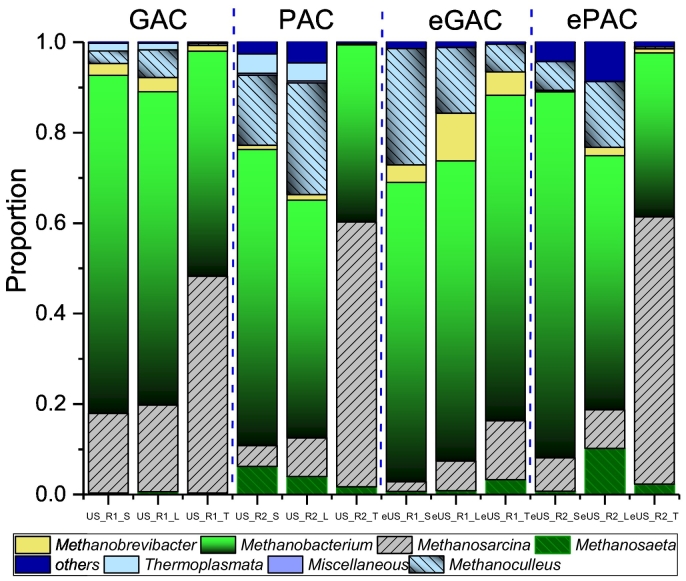
Archaeal taxonomic distributions.